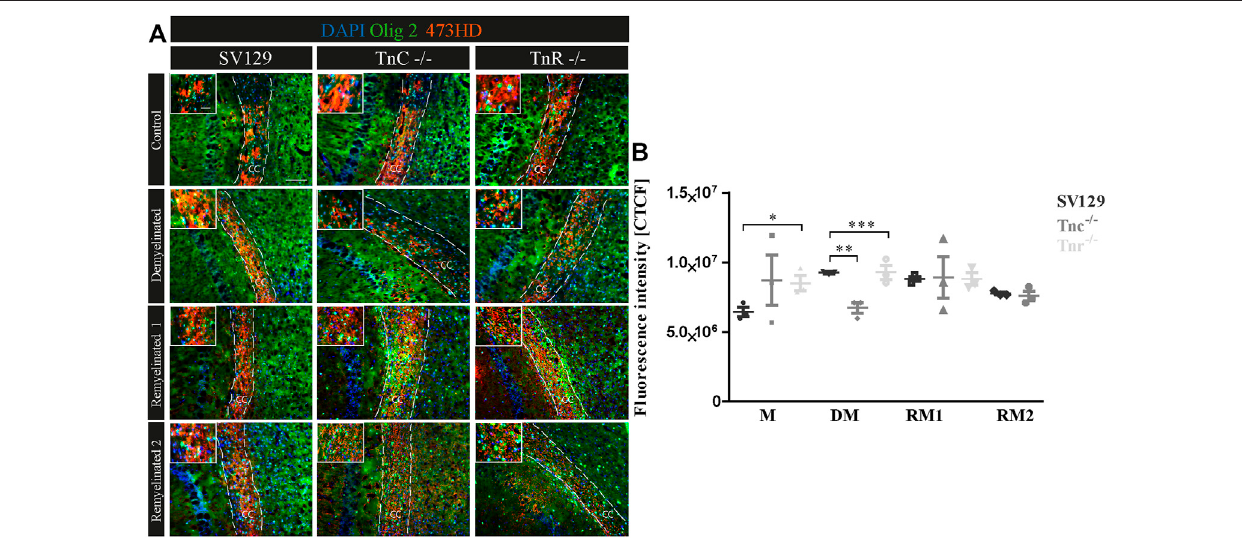
FIGURE 8 | (A,B) Comparative analysis of Olig2/473HD-staining in the corpus callosum of SV129, Tnc − / − , and Tnr − / − mice under control, demyelinated, and remyelinated conditions. Immunohistochemical labeling (A) with antibodies against Olig2 (detects all oligodendroglia) and 473HD (detects chondroitinsulfate) ofSV129, Tnc − / − ,and Tnr − / − brainsections underdifferentconditions(control, demyelinated, one-weekremyelinated,two-weeksremyelinated)isshown. (B) Quantitative analysis of the 473HD fl uorescence intensity (CTCF) in the corpus callosum above the region of the hippocampus. The fl uorescence intensity was signi fi cantly reduced within the corpus callosum of Tnr − / − in control and demyelinated conditions. DAPI stains cell nuclei in blue. Scale bar: illustration: 100 μ m, detail pictures: 50 µm. N = 3 animals were used for each group and genotype, and at least n = 500 cells were evaluated for each individual animal.